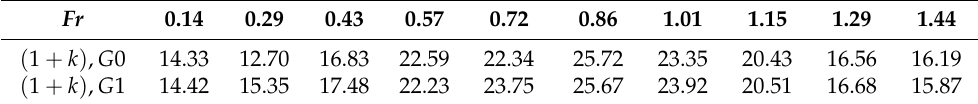
Table 6. (1 + k ) of HSAV with or without Flanks at different Froude